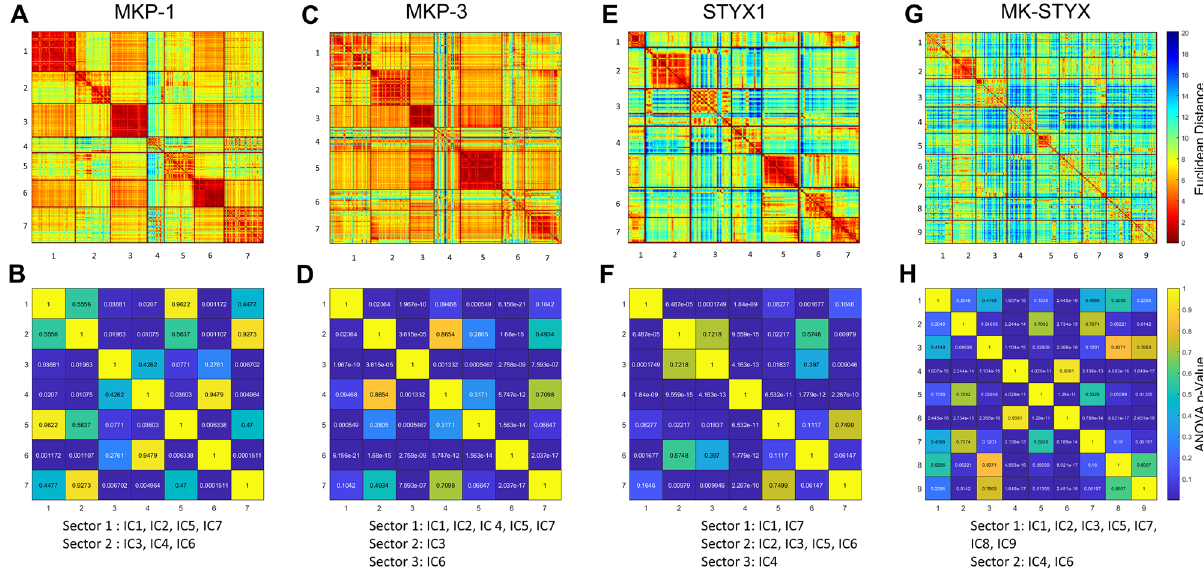
Figure 5. IC heatmap and sector membership analysis for the MKPs, STYX, and MK-STYX. ( A , C , E , G ) The heatmap shows the Euclidean distance between the 7 (MKP-1, MKP-3, or STYX1) or 9 (MK-STYX) selections (top 5% of positions) from 7 ICs or 9 ICs. A hotter color such as red, yellow and orange indicates a strong correlation (short Euclidian distance), whereas a colder color such as green or blue indicates a weak correlation (far Euclidian distance). ( B , D , F , H ) With a large number of residues and indistinguishable correlation coloring among the 7 or 9 selections, an ANOVA test is run between every pair of selections to determine the difference between selections and therefore, to determine sectors. A small enough p-value results in most ICs merging into a giant sector, since most proteins serve one function as an entirety. Thus, a p-value cutoff of 0.1 instead of 0.05 is chosen to prevent excessive merging of ICs. If two selections have a p-value smaller than the cutoff, they are statistically different and should be assigned to different sectors. If two selections have a p-value equal to or bigger than the cutoff, they are not statistically different and should be assigned to the same sector. Two sectors were defined. Heatmaps were generated by MATLAB (https:// www. mathw orks. com/ downl oads/ web_ downl oads/ downl oad_ relea se? relea se= R2021a) and the layout was designed in Microsoft